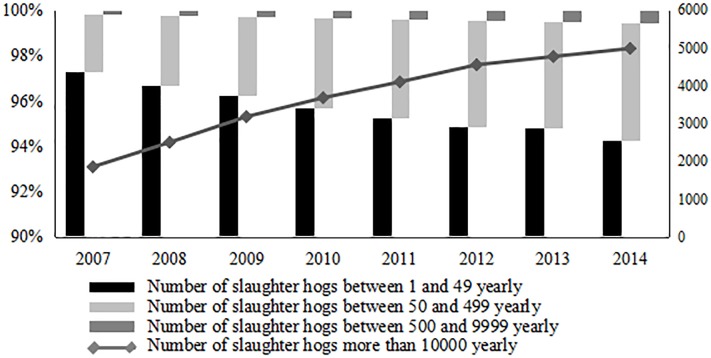
Trend of hog breeding scale in 2007–2014.